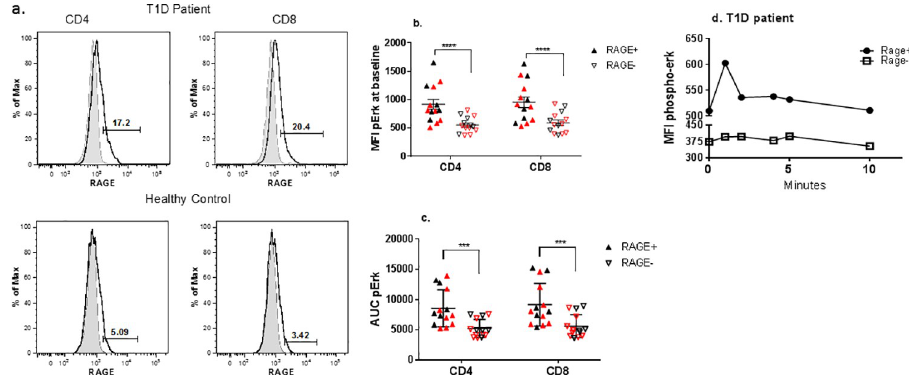
Fig 1. Signaling in RAGE+ and RAGE - primary T cells from T1D patients and healthy control subjects. (a) Intracellular RAGE staining in CD4+ and CD8+ T cells from a representative patient with T1D (top) and a healthy control subject (bottom). Shaded histograms are staining with the isotype control. Solid lines are staining with anti- RAGE antibody. (b) The MFI of pErk in unstimulated CD4+ and CD8+ T cells (identified by FACS staining) from healthy control subjects and patients with T1D. Each symbol represents a cell donor. Red symbols indicate cells from patients with T1D (n = 8), black symbols represent healthy control subjects (n = 6). Filled symbols are RAGE+ and open symbols are RAGE- cells. ( ���� p < 0.001, two way ANOVA for paired samples of RAGE+ and RAGE- in each subject with Sidak’s multiple comparison). (c) The AUC of pErk MFI in RAGE+ and RAGE- CD4+ and CD8+ T cells that were activated with cross-linked anti-CD3 mAb. Each symbol represents a cell donor as indicated in b. (Two way ANOVA for paired samples (RAGE+ and RAGE-) with Sidak’s multiple comparison, ��� p < 0.001). (d) A representative example of the phosphoflow Erk1 response used to generate the data shown in (b) and (c) is shown for CD4+ cells from a patient with T1D.